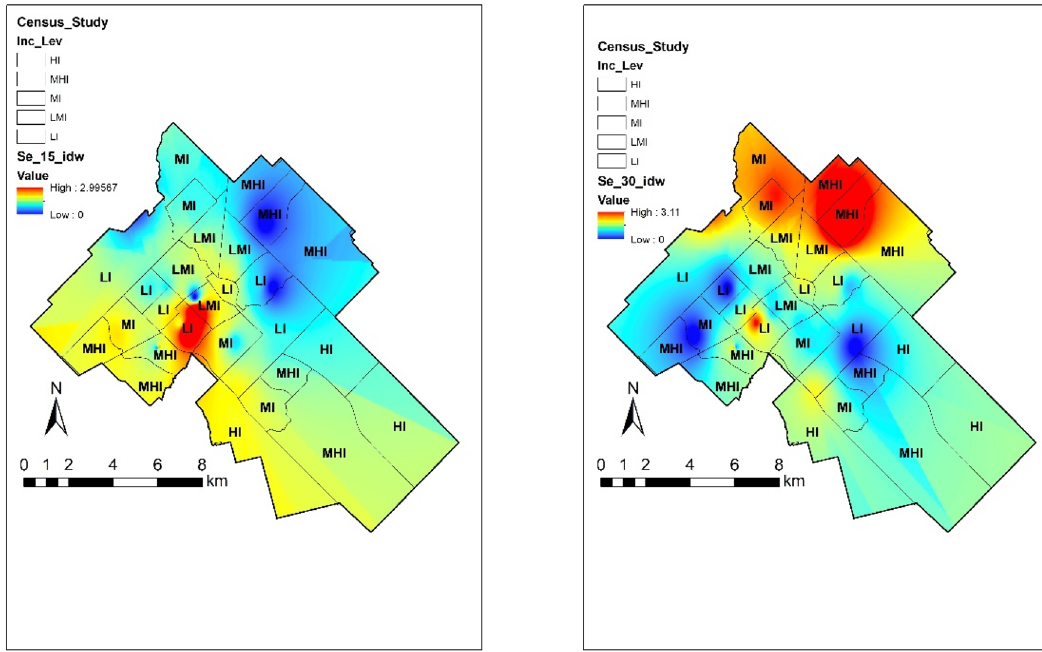
Figure 6. Spatial distribution of Se in Guelph in the 0–15 and 15–30 cm depth with varying income conditions. The map was prepared by using the “Geostatistical Analyst” tool in ArcGIS 10.4 (https:// deskt op. arcgis. com/